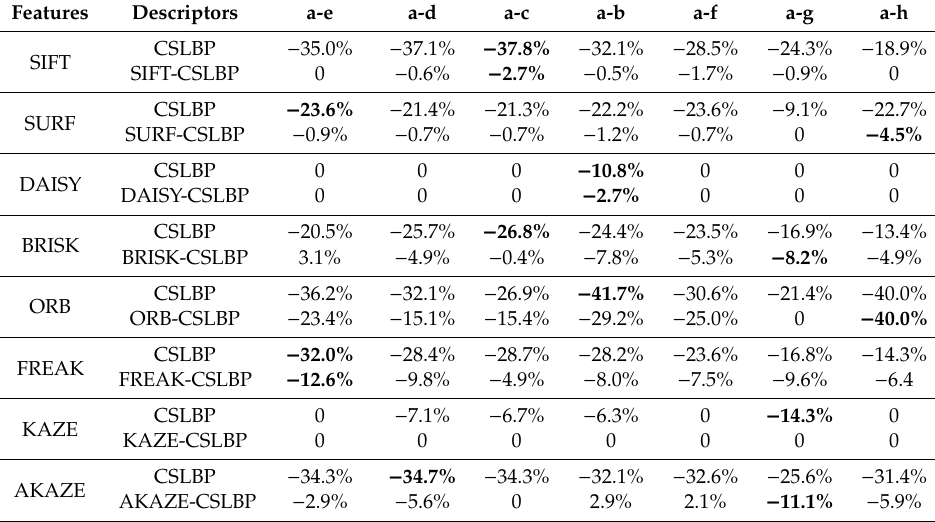
Figure 16. Matching results of the precision of Graffiti sequence for the eight original, the CSLBP, and the combined descriptors. The X label represents the matched images of Graffiti sequence, and the Y label denotes the precision for each descriptor. ( a ) SIFT features; ( b ) SURF features; ( c ) DAISY features; ( d ) BRISK features; ( e ) ORB features; ( f ) FREAK features; ( g ) KAZE features; ( h ) AKAZE features. Table 7. The reduced values of recall for the CSLBP and the combined descriptors compared to the original descriptors of Graffiti sequence.